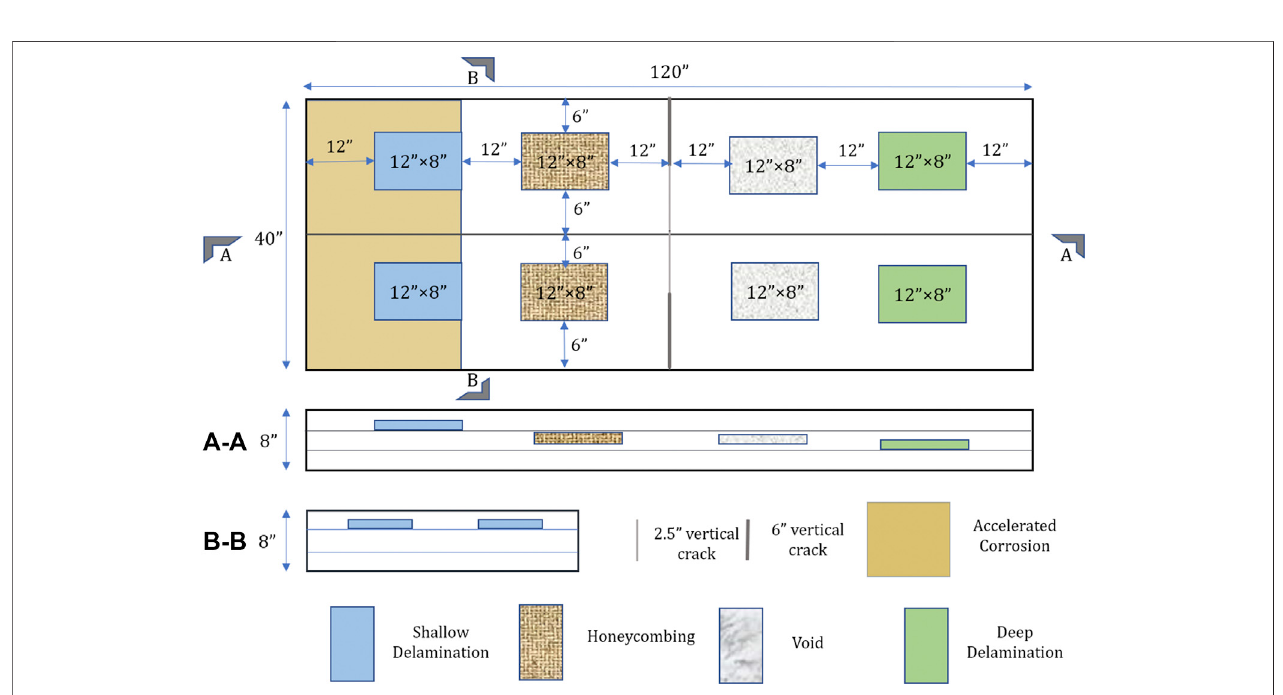
FIGURE9| Laboratory-scalebridgedeckspecimendesign.Section (A-A) showsthelocationforeachdefecttypewithrespecttoslabdepth.Section (B-B) shows defect placement for shallow delaminations. The placement of other defects in the cross-section is similar, accounting for variations in depth.